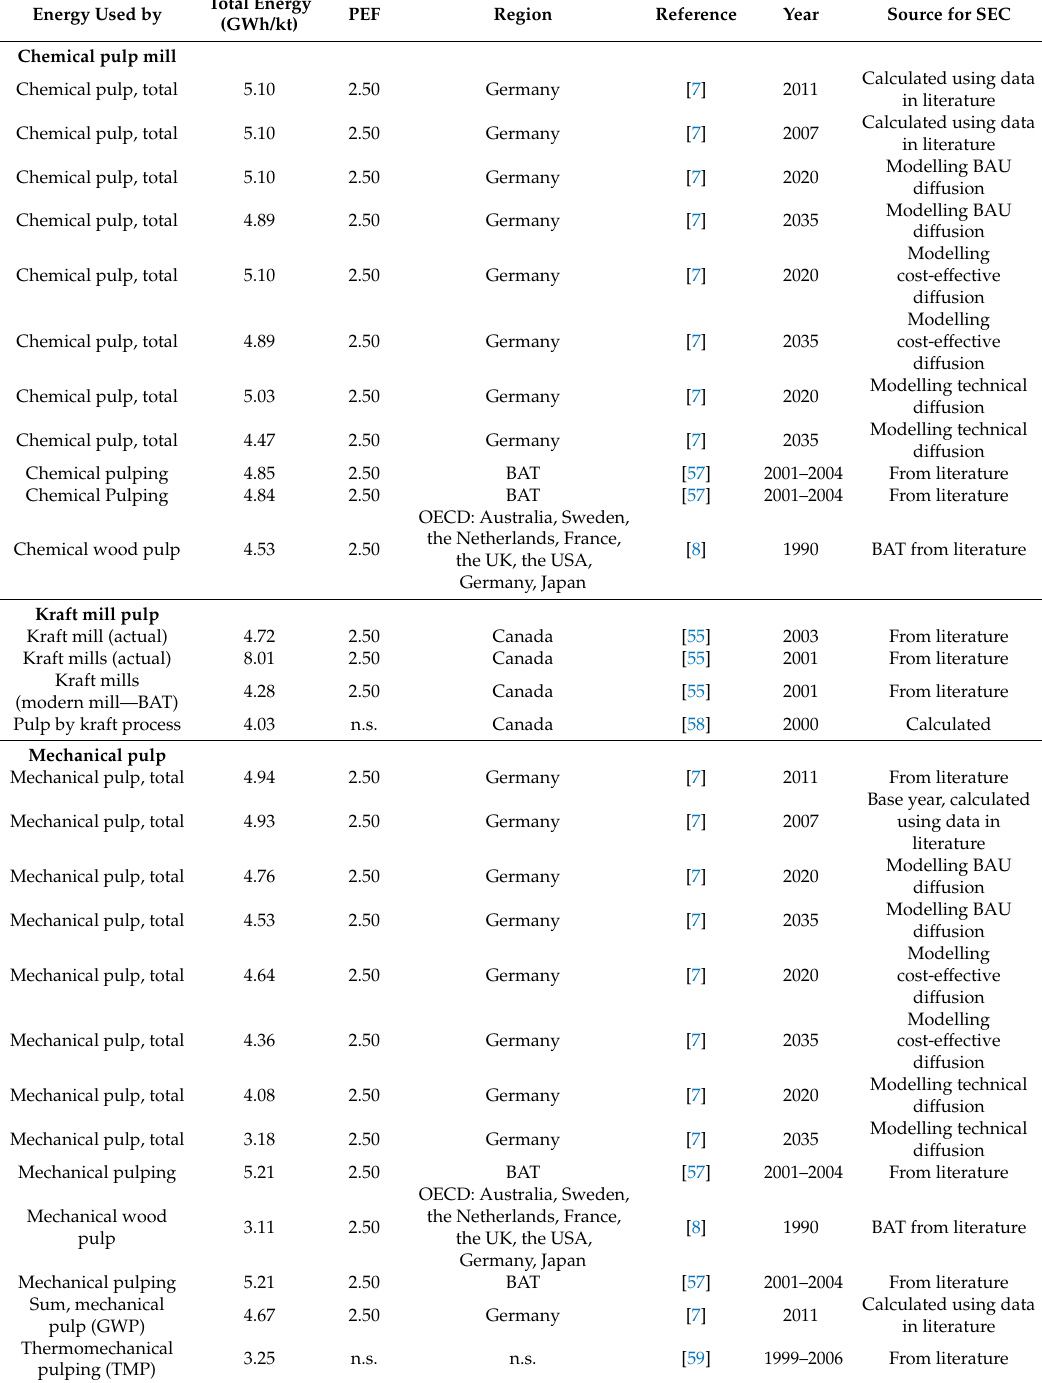
Table A1. Examples of SEC for various pulps listed alphabetically. BAT—Best available technology. BAU—Business as usual. OECD—Countries that are members of the Organisation for Economic Co-operation and